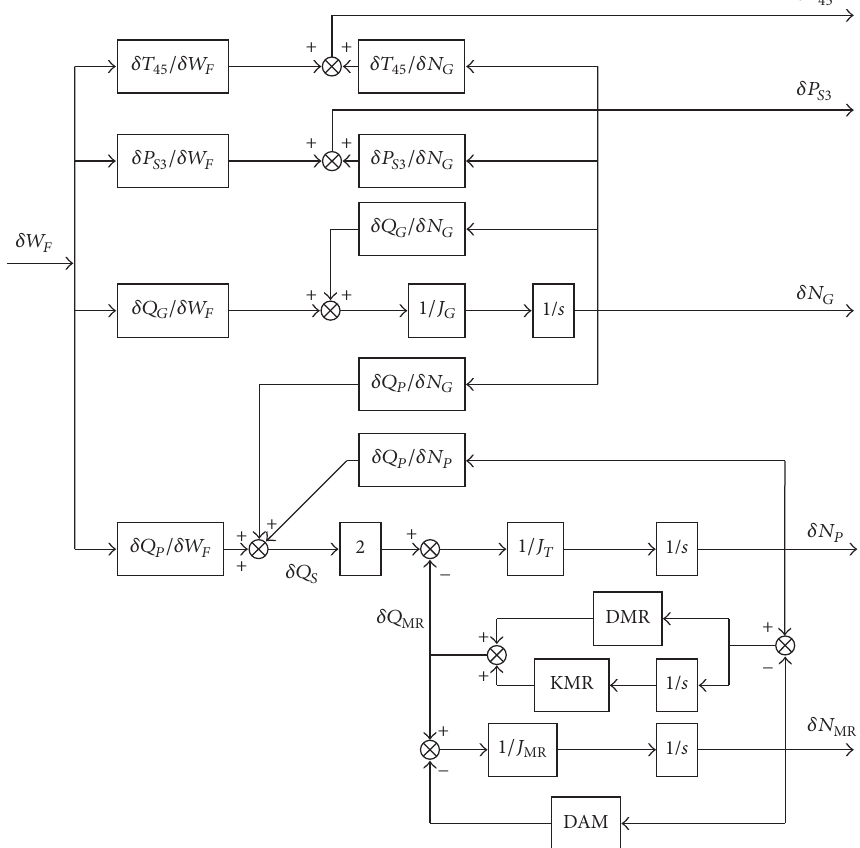
Figure 2: Block diagram of the simplified linearized gas generator and rotor system.